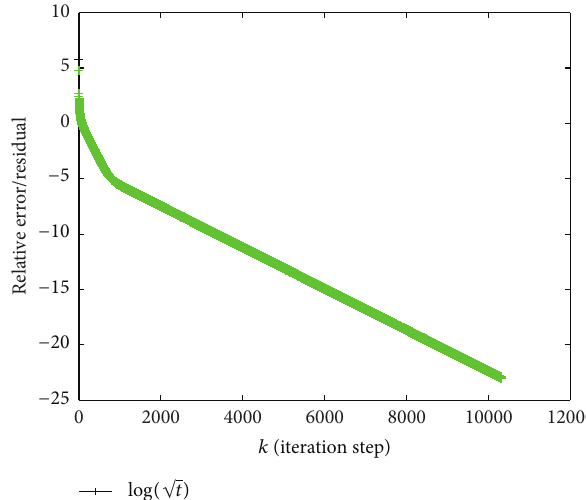
Figure 1: The obtained sequence ‖Δ𝑋‖ by Algorithm 3 for Example 1.